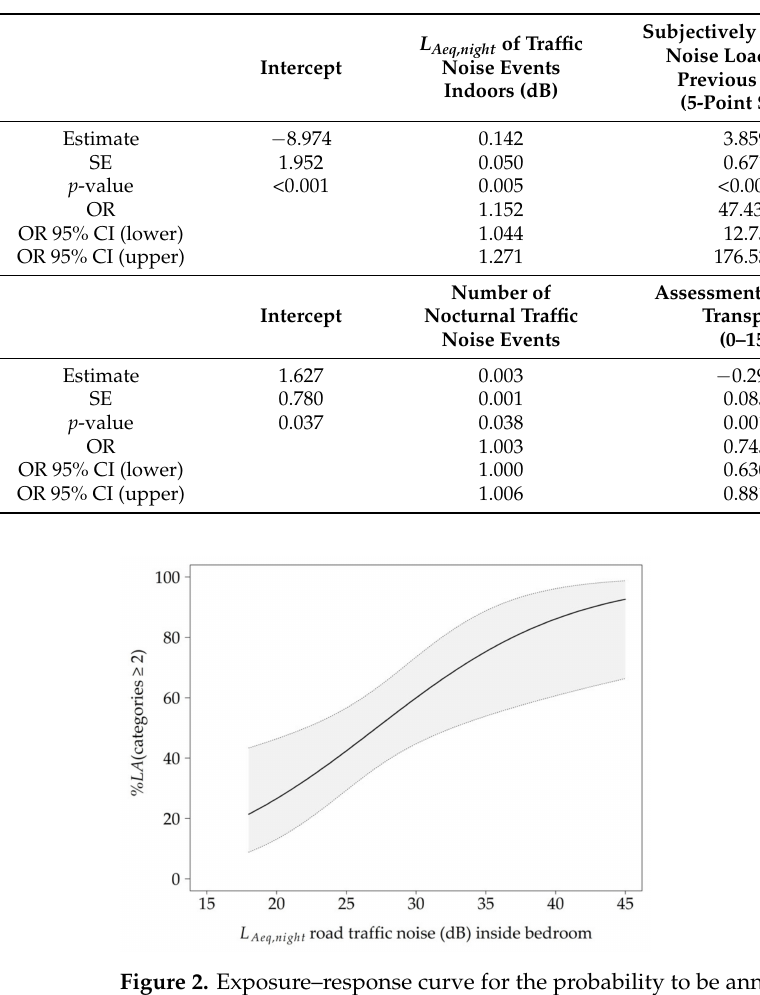
Table 2. Random effects logistic regression models GEE 1 and GEE 2 calculated by Generalized Estimating Equation with regard to the effect of acoustical and non-acoustical predictors on annoyance.